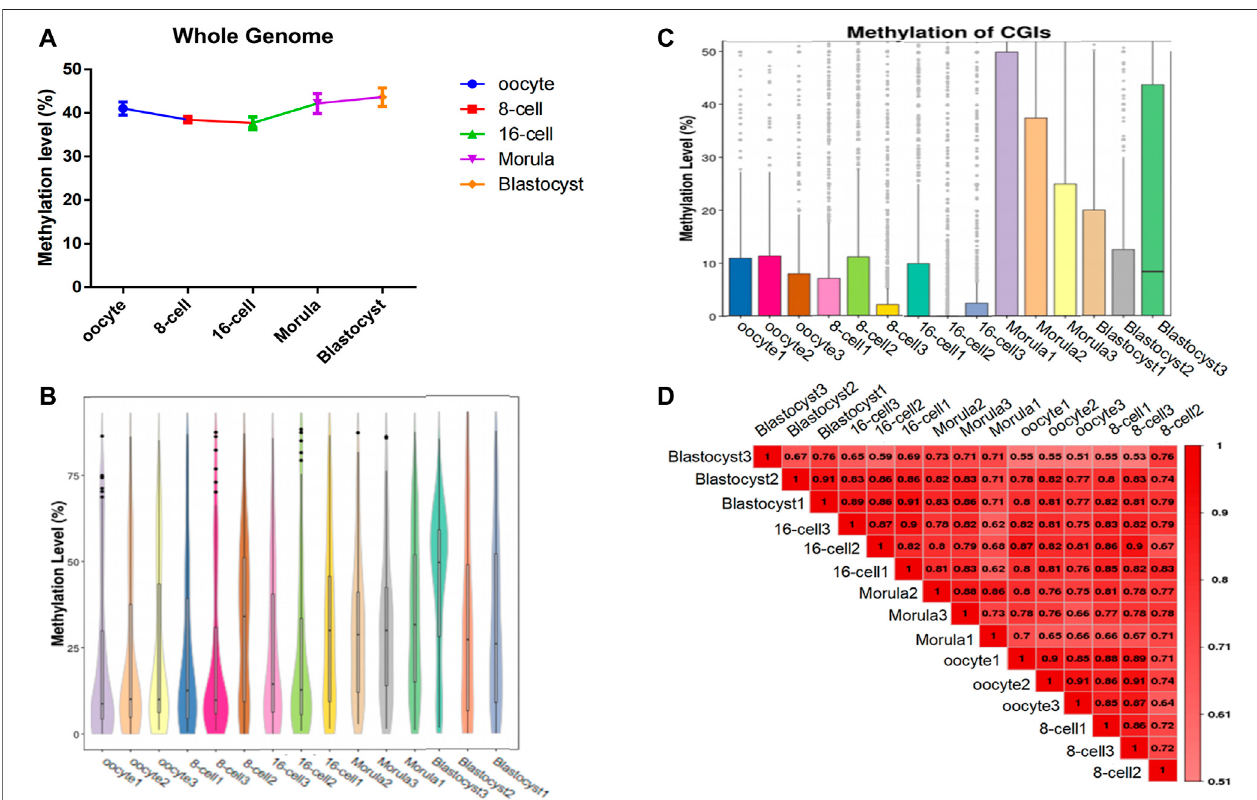
FIGURE 1 | Genome-wide methylation dynamics during the development of sheep preimplantation embryos. (A) Whole-genome DNA methylation map in each oocyte/embryo.Thehorizontalaxisrepresentsdifferentcellsandtheverticalaxisrepresentsthegenome-widemethylationlevelofdifferentcells. (B) Whole-genewindow methylation map in each oocyte/embryo. Violin plot of the genome-wide distribution of methylation levels of whole-gene 2-kbp windows. The horizontal axis represents different cells; the vertical axis represents the level of methylation of the whole-genome window of different cells. (C) Methylation level distribution of CpG islands (CGIs)ineachoocyte/embryo.ThehorizontalaxisrepresentsthecellsampleandtheverticalaxisrepresentsthemethylationlevelofdifferentcellularCGIregions. (D) The methylation parttern correlation analysis in sheep oocytes and early embryos. The genome-wide methylation level was calculated using the sliding window method (2 kbp), and Pearson ’ s correlation coef fi cient of all the samples was calculated. The closer the correlation coef fi cient is to 1, the higher the similarity of the whole-gene methylation pattern between